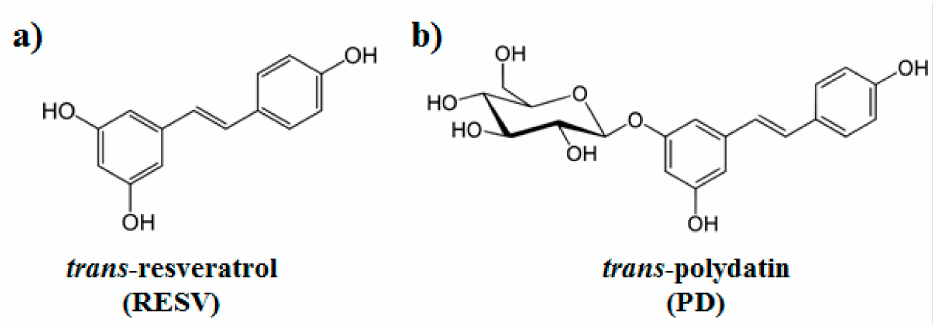
Figure 1. Chemical structures of ( a ) trans-resveratrol (RESV) and ( b ) trans-polydatin (PD).